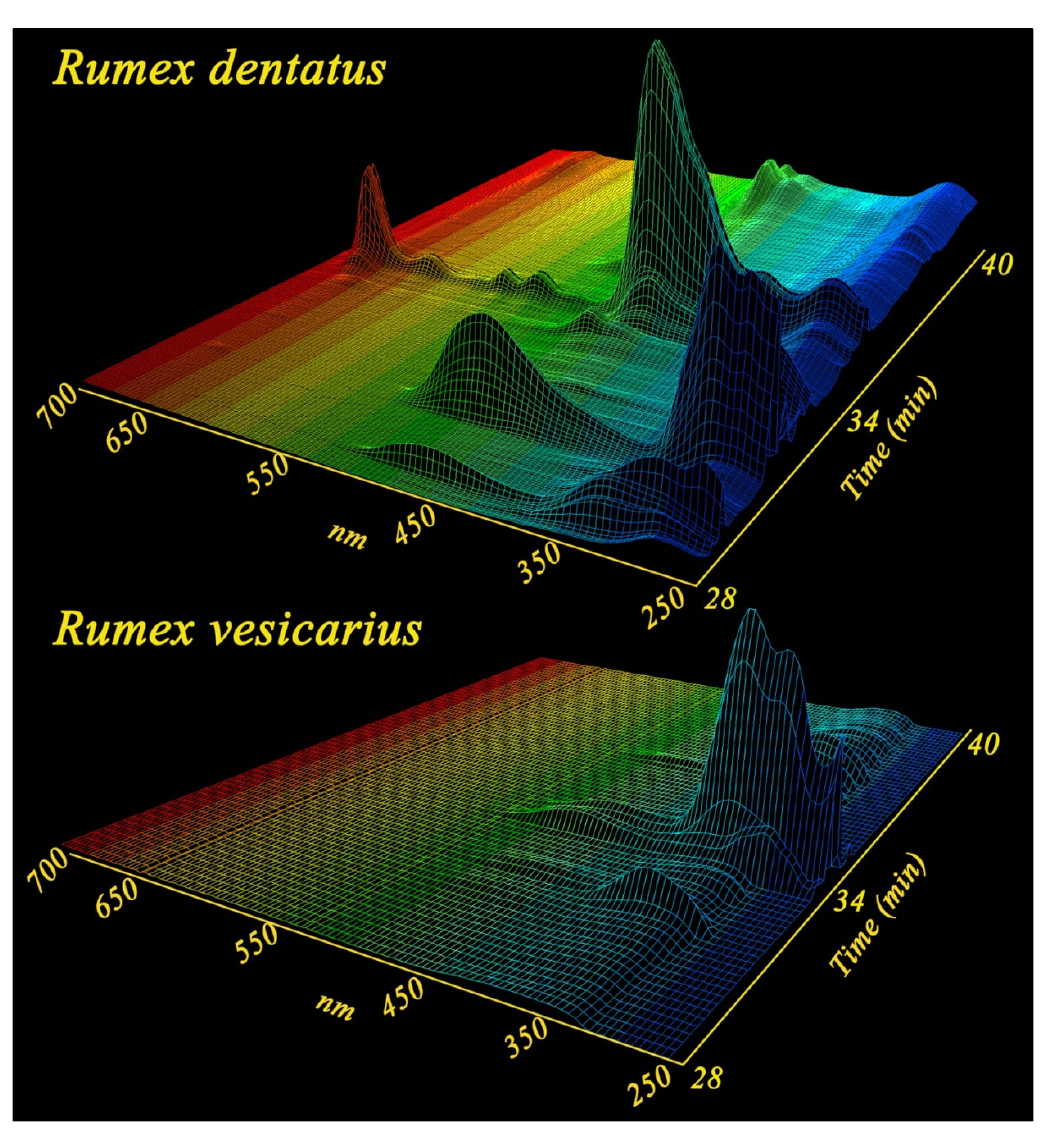
Figure 5. Ultra violet/visible absorption spectra LC chromatograms of Rumex dentatus and Rumex vesicarius